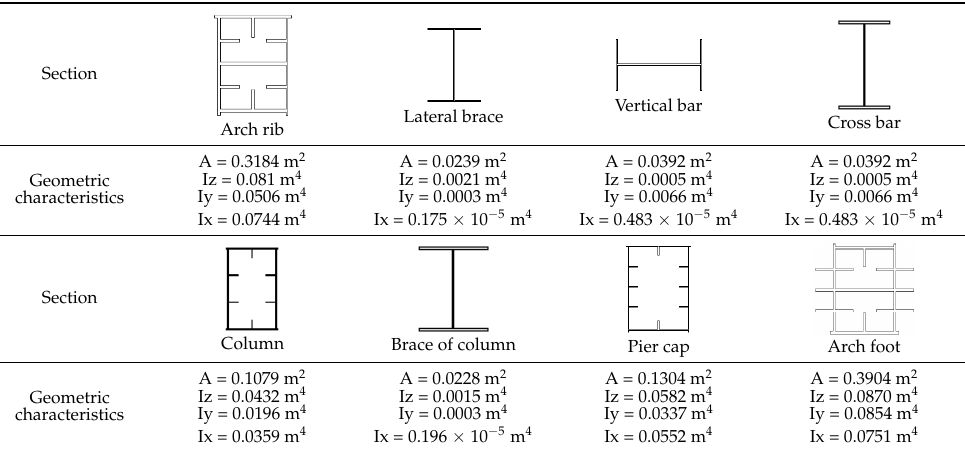
Table 3. Material Table 3. Material parameters. Table 3. Material parameters. Table 3. Material parameters. Table 3. Material parameters. Table 3. Material parameters. Table 3. Material parameters. Table 3. Material parameters. Table 3. Material parameters.